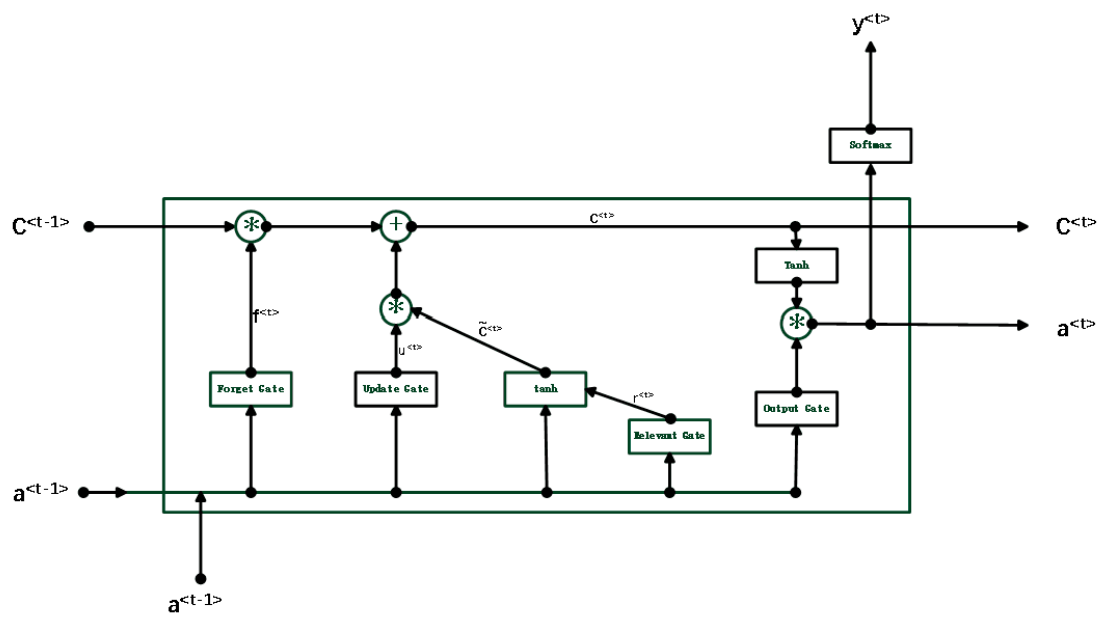
Figure 10. Structural diagram of RLSTM.